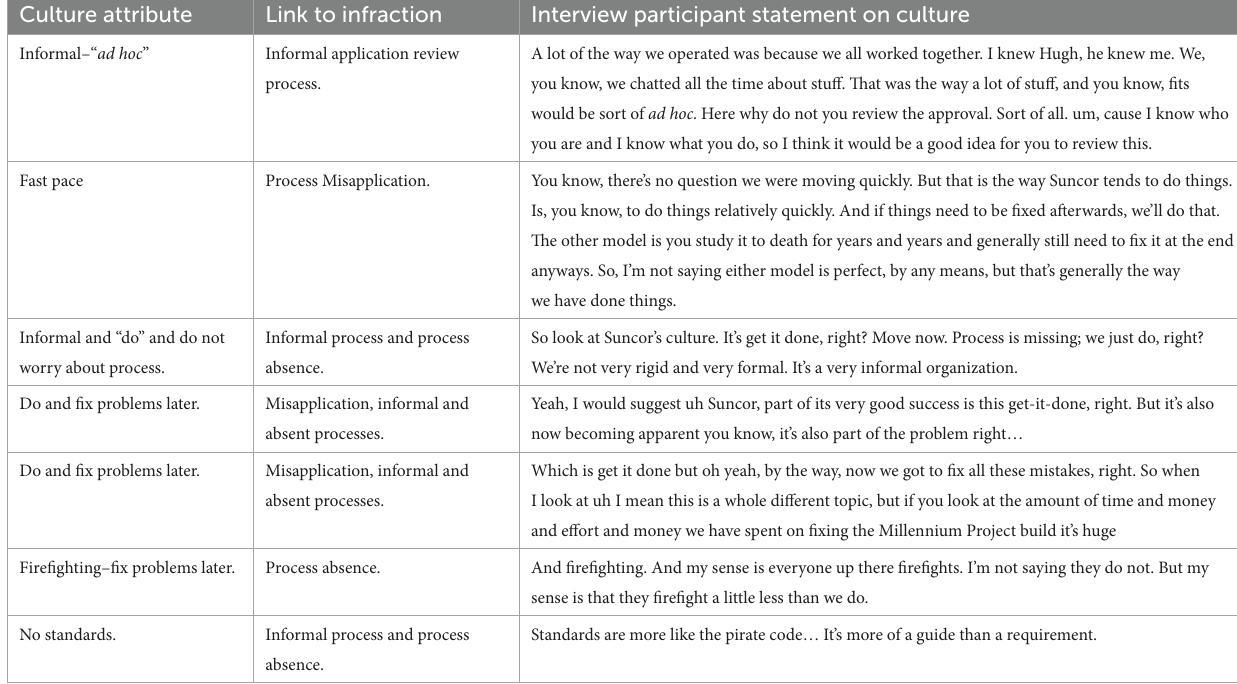
TABLE 3 Culture